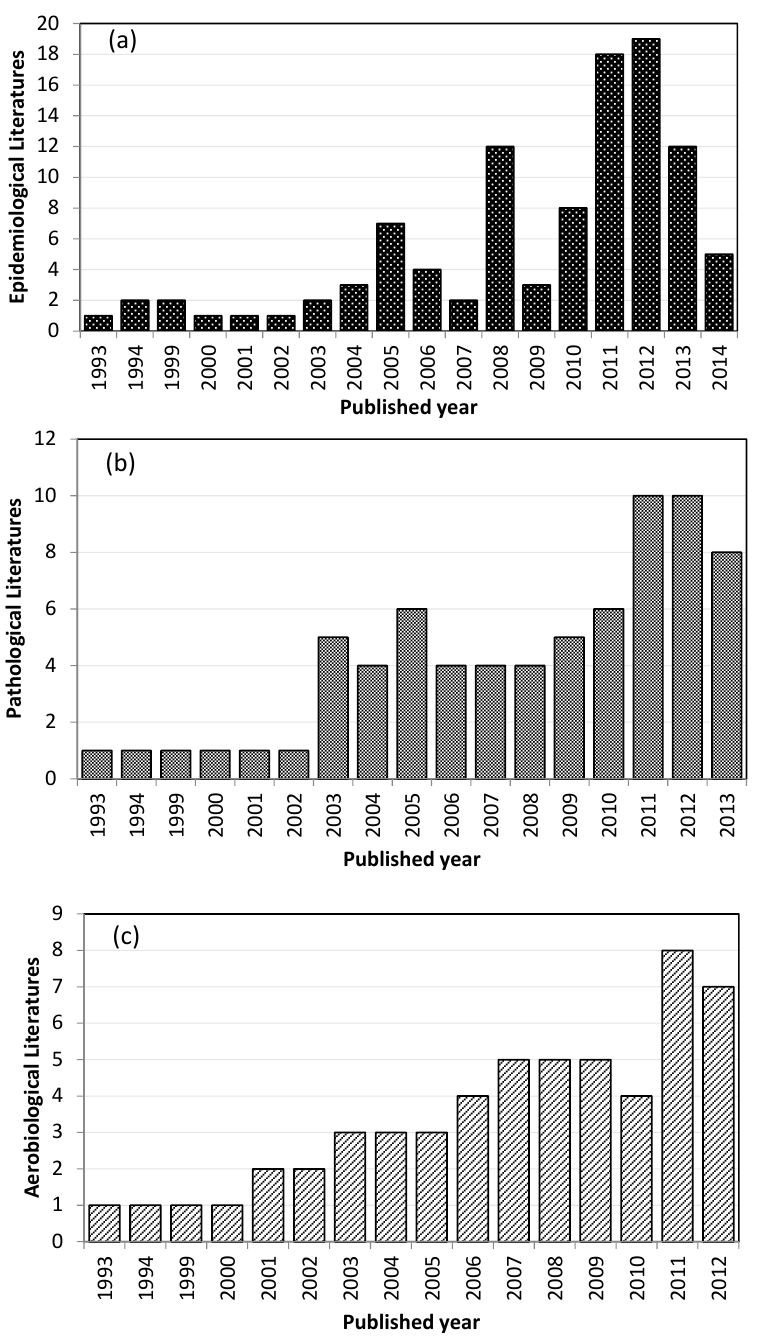
Figure 2. Number of published articles related desert dust to human health for ( a ) epidemiology; ( b ) pathology; and ( c ) airborne microorganisms.